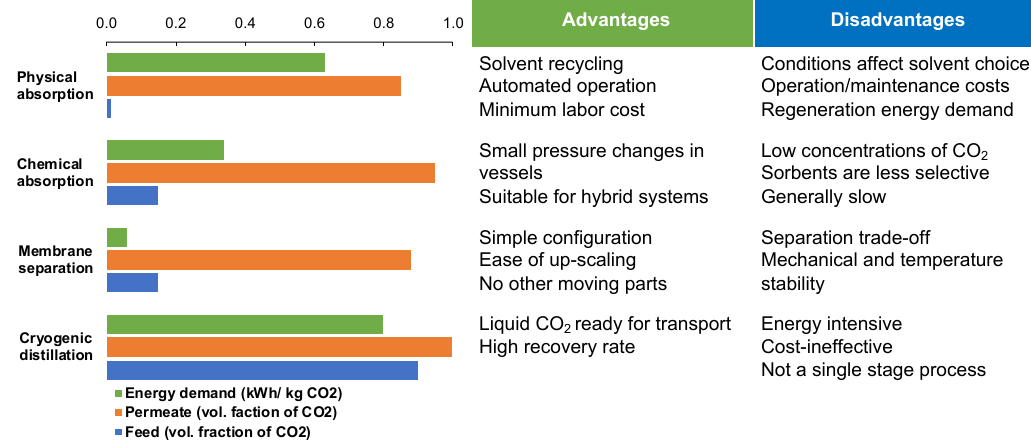
Figure 1. Comparison of existing CO 2 capture technologies based on the energy demand for achieving certain volumetric ratio of CO 2 in product stream and respective CO 2 content in feed stream presented alongside the most common advantages and disadvantages of each process. The numerical data is collected across several publications and presented as reported